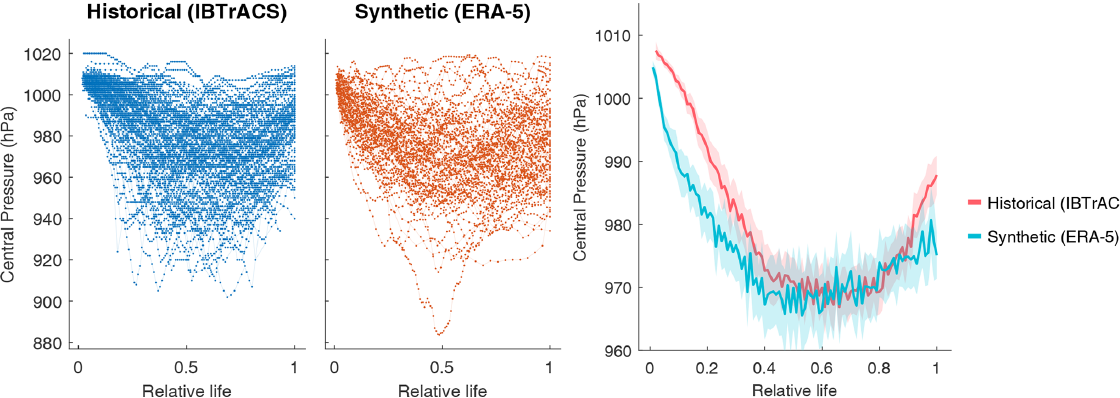
Figure 10. Individual historical vs. synthetic depression dynamics in the North Atlantic basin, and the confidence